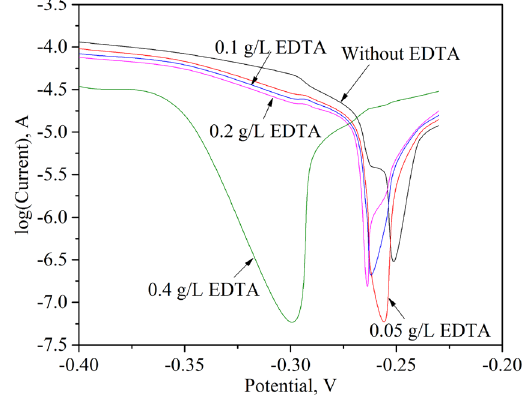
Figure 7: Tafel plots of gold dissolution at di ff erent EDTA mass